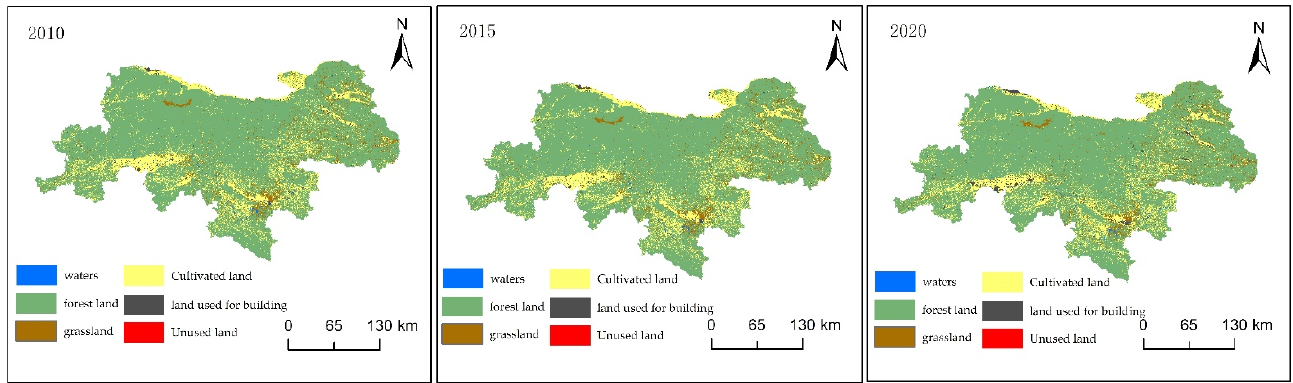
Figure 4. Land-use types of Qinling Mountains in 2010, 2015, and 2020.